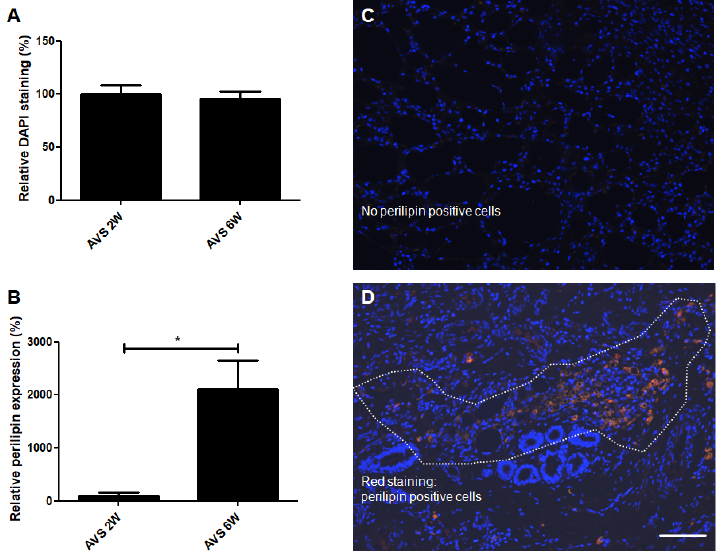
Figure 8. DAPI (cell nuclei) and perilipin (adipocytes) co-staining of vascularized mSVF explants after two and six weeks. ( A ) Statistical analysis of DAPI staining of vascularized mSVF explants after two and six weeks showed no statistical difference. ( B ) A statistical evaluation of perilipin staining, by contrast, demonstrated a significant increase in perilipin expression after six weeks. Representative DAPI (blue) and perilipin (red) co-staining of mSVF explants after ( C ) two weeks and ( D ) six weeks are illustrated. The white dotted line indicates an accumulation of perilipin positive, red cells. Bar: 100 µm. * p < 0.05.